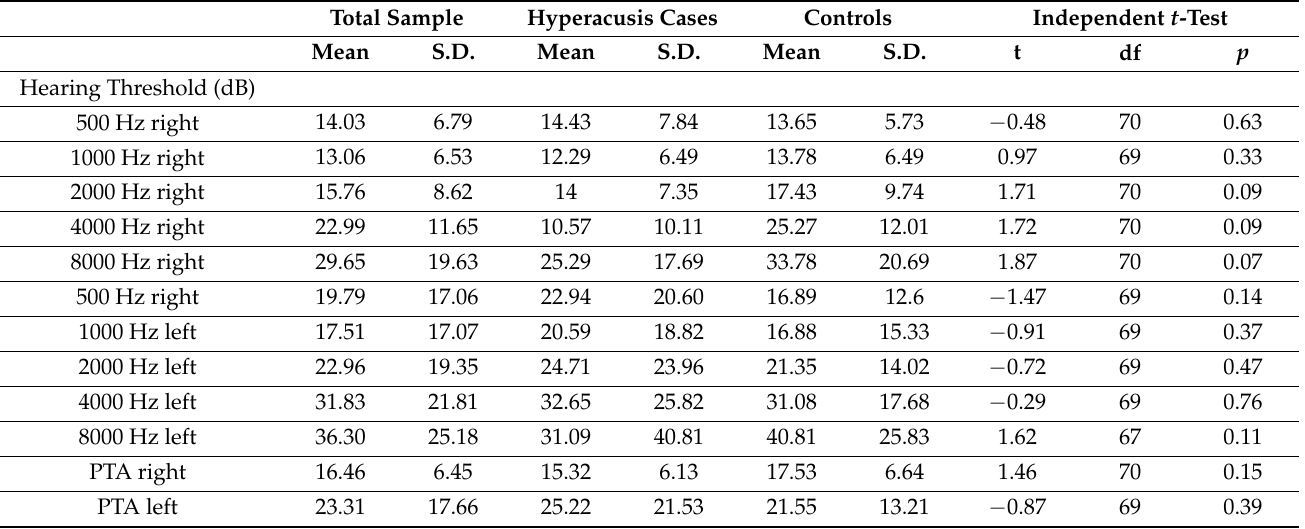
Table 1. Mean scores and standard deviations of pure tone audiometry and PTA (expressed in decibel) are displayed for both ears. The significance level is reached for p values < 0.05 and <0.005. Total